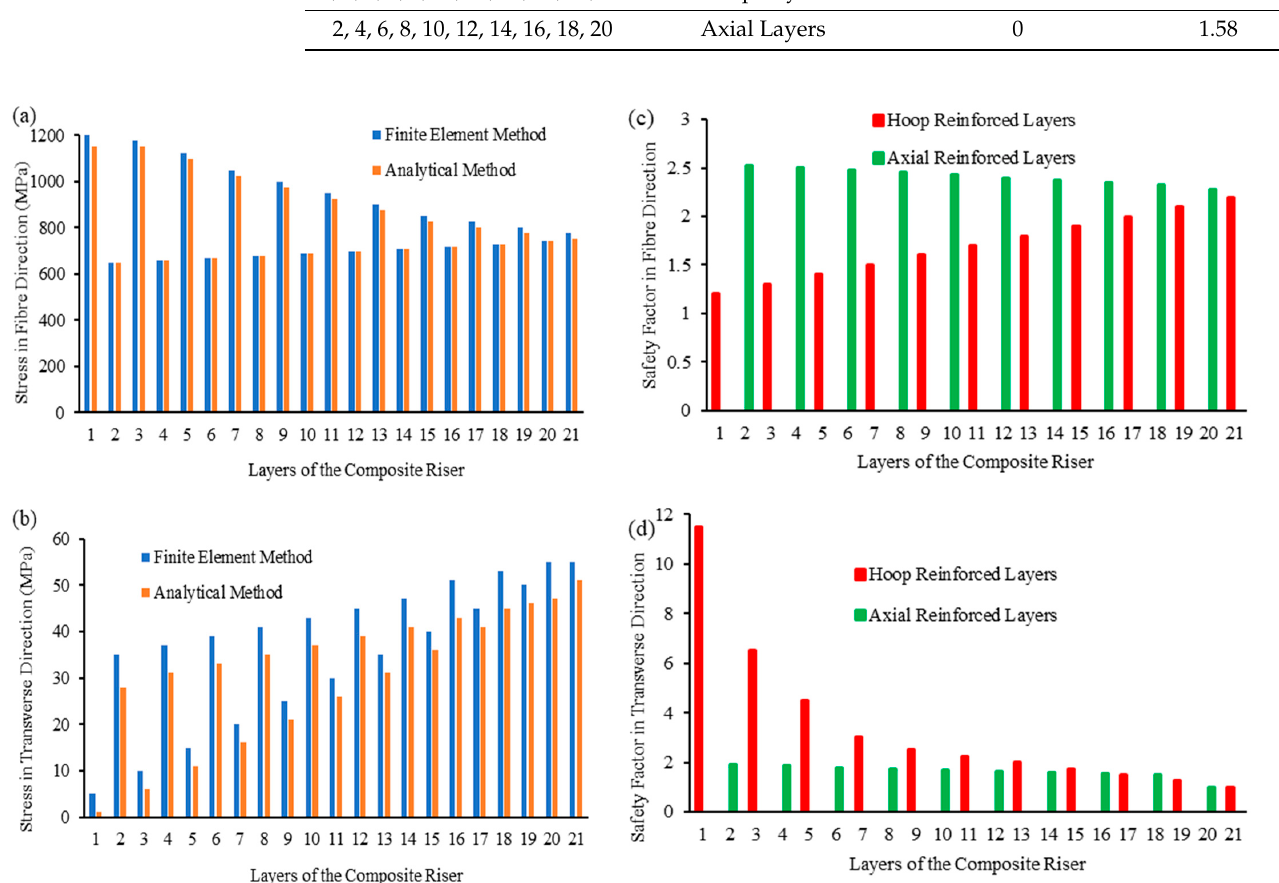
Figure 11. Result of composite riser model’s conventional design for AS4/PEEK utilising PEEK liner under burst case showing the axial and hoop reinforcements along ( a , c ) fibre and ( b , d ) transverse directions for finite element method vs. analytical method.